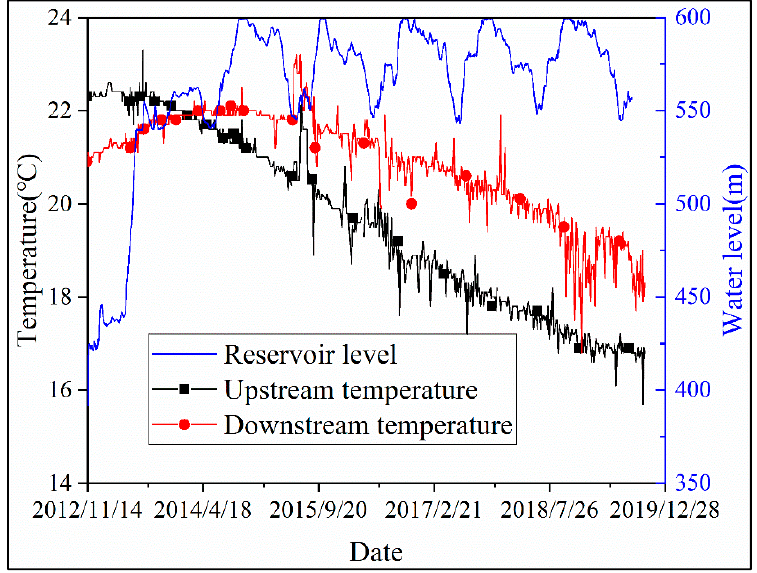
Figure 7. The process at the bottom of the dam site.